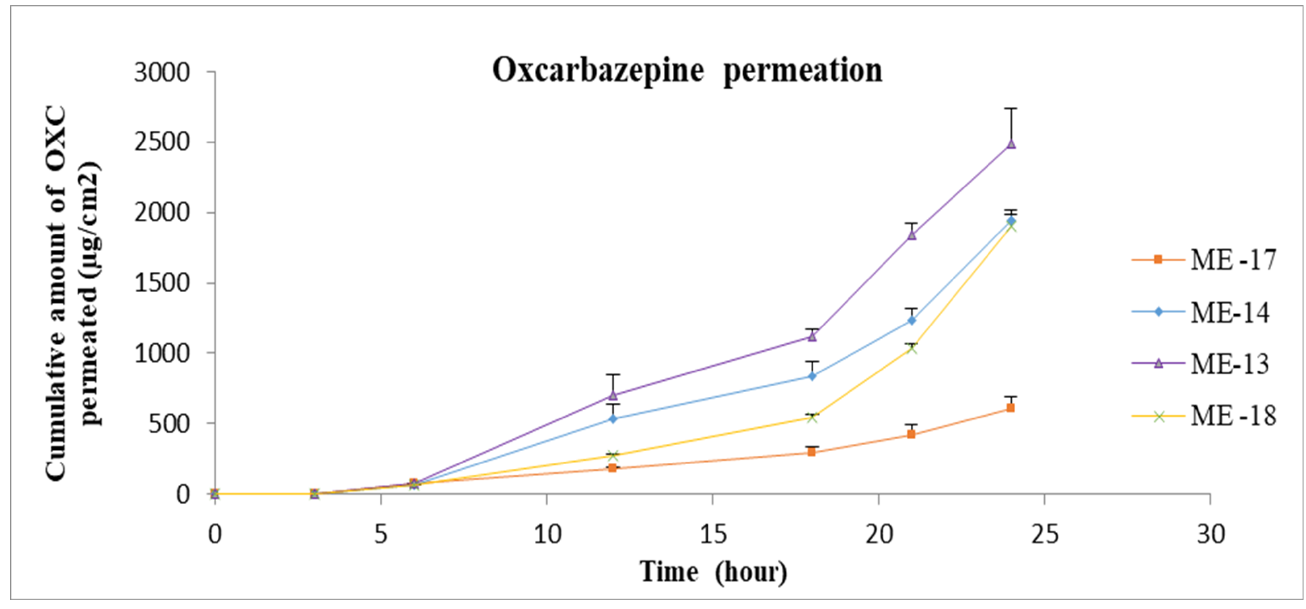
Figure 9. In vitro cumulative amount of OXC permeated per unit area versus time across the human cadaver skin. Each point represents the mean ± S.D. of three replicates in the absence of multiple donors. ME13-10%Cin, 25%T80, 25%TRC, 40%Water. ME14-10%Cin, 30%TRC, 30%LS, 30%Water. ME17-5%Cin, 20%T80, 20%TRC, 55%Water. ME18-5%Cin, 25%TRC, 25%LS, 45%Water.